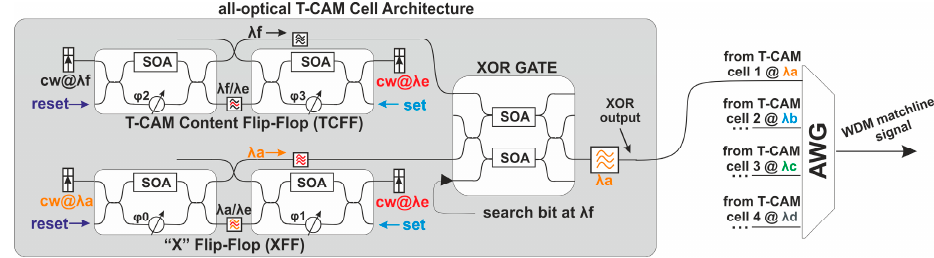
Figure 7. All-optical T-CAM cell architecture with two FFs (TCFF & XFF) and a XOR gate and a T-CAM row’s AWG multiplexer for four indicative T-CAM cells.